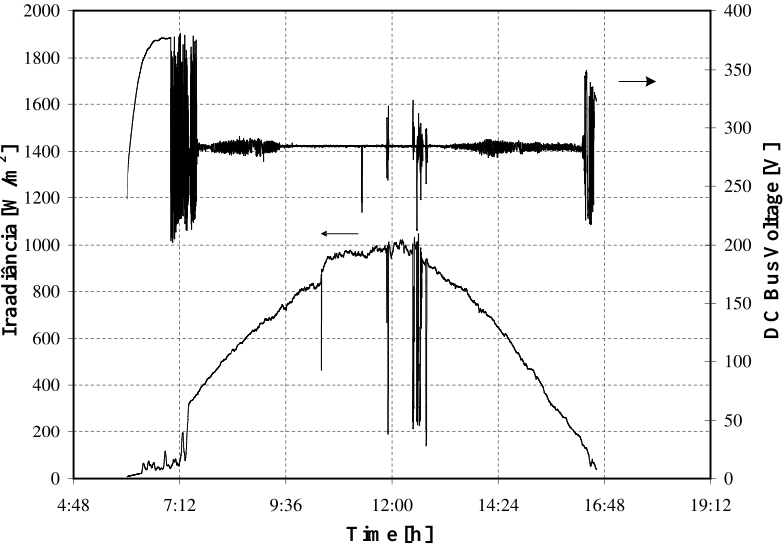
Figure 9. Variation in DC voltage in a PVPS with VSD containing an embedded